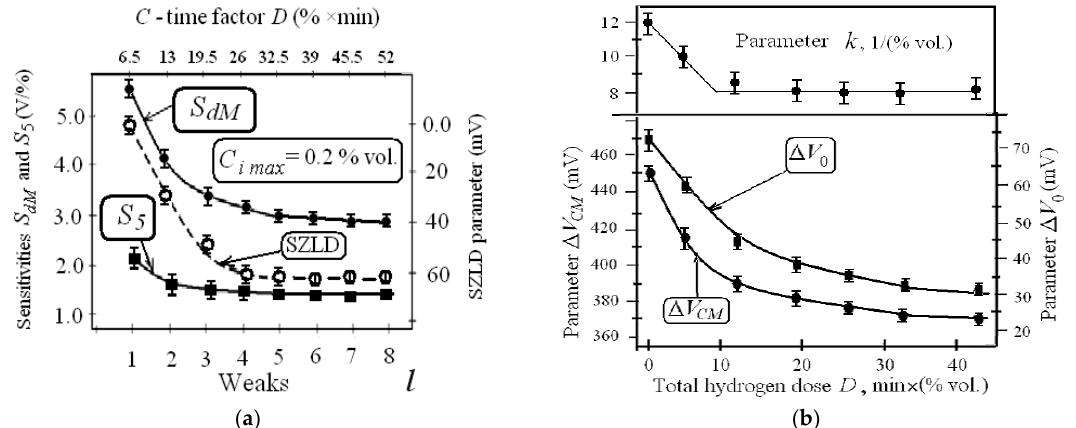
Figure 6. The changes in response parameters as a function of D : ( a ) The changes of SZLD parameters, sensitivities S dM and S 5 during the week’s l -cycles; ( b ) Parameters k and ∆ V 0 , maximum response amplitudes ∆ V CM vs. D . Symbols correspond to experimental data and lines are approximations.